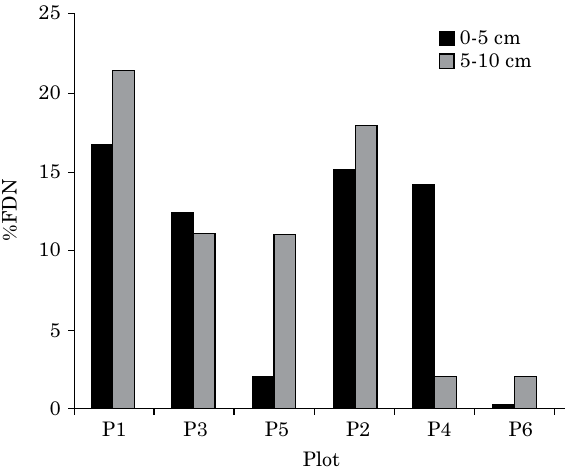
figure 3. Percentage of fertilizer-derived nitrogen (%fdN) in the 0-5 and 5-10 cm layers in Untilled plots (P1, P3 and P5) and tilled plots (P2, P4 and